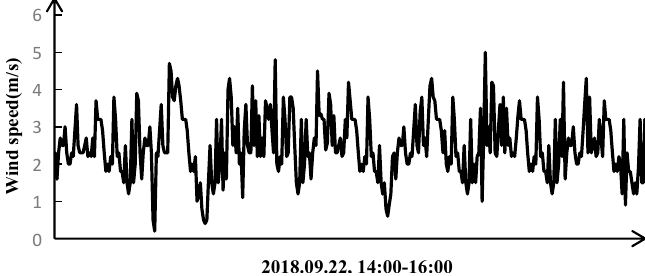
Figure 2. Wind speed time history curve during the test period.